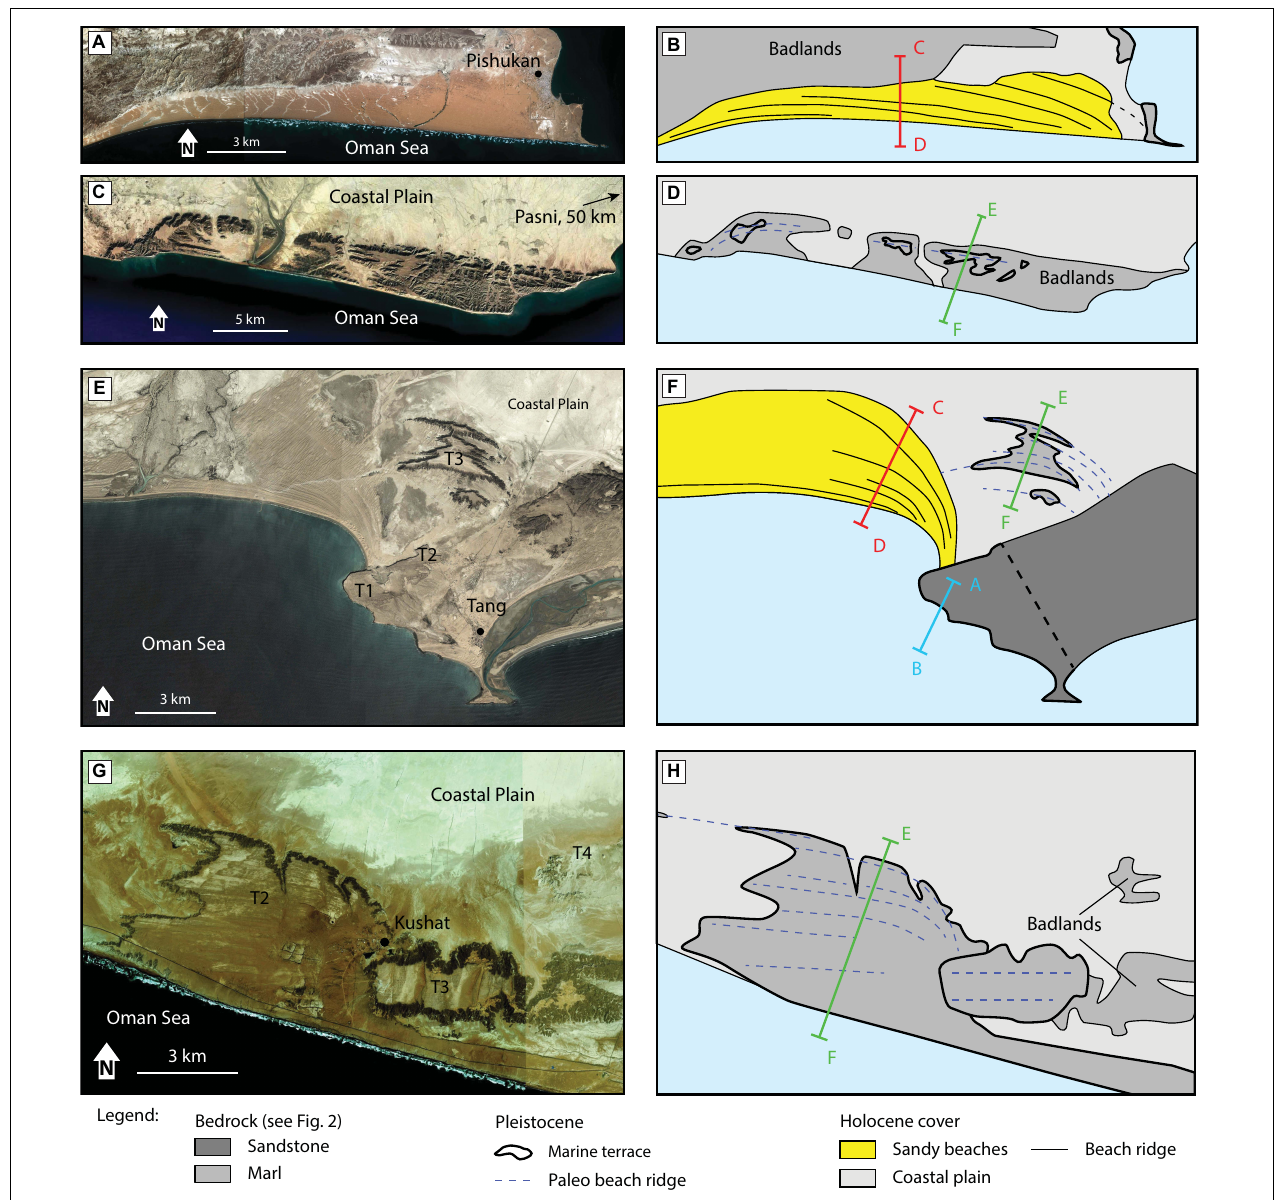
FIGURE 8 | Marl-type beaches and terraces. Colored profiles are the sketches from Figure 7 . (A,B) Pishukan beach (Pakistan), a Holocene bay beach built on marl bedrock. Notice the sharp northern beach limit carved by wave erosion. (C,D) Ras Shamal Bandar, a terrace ∼ 50 km west of the village of Pasni (Pakistan). Notice the morphological similarities with Pishukan beach pictured in panel A , though here, the paleocliff and badlands beyond are eroded down to the coastal plain level. (E,F) Tang terraces. T3 is an uplifted version of the nearby Holocene beach (yellow in panel F ), notice the morphological similarities. The Holocene beach is deposited in the leer of T1. T3 was created in a similar fashion, by wave-diffraction around a rocky headland (probably the one outcropping in the east of the picture). (G,H) Pasabander marl-type terraces; T2, T3 and T4. The morphology of T2 is similar to the crenulated Holocene bay beaches (e.g., Figures 7G , 8E ), and was probably built by wave-diffraction around T3. F,H inspired from the maps of Normand et al.